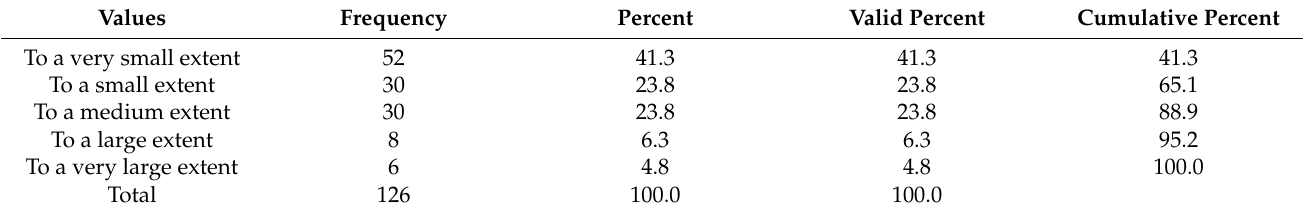
Table 2. The extent to which educational platforms were used before the pandemic to pre- pare/conduct teaching classes.